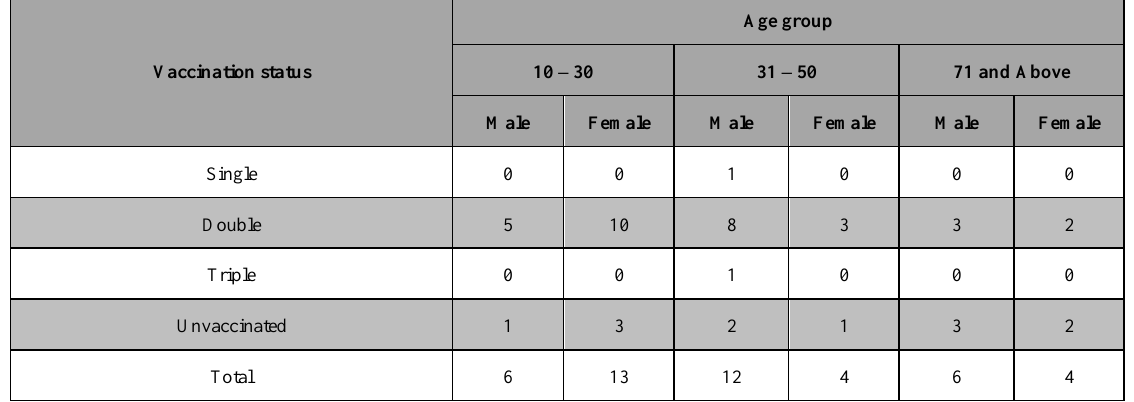
Table 4. Vaccination status of patients with respect to age and